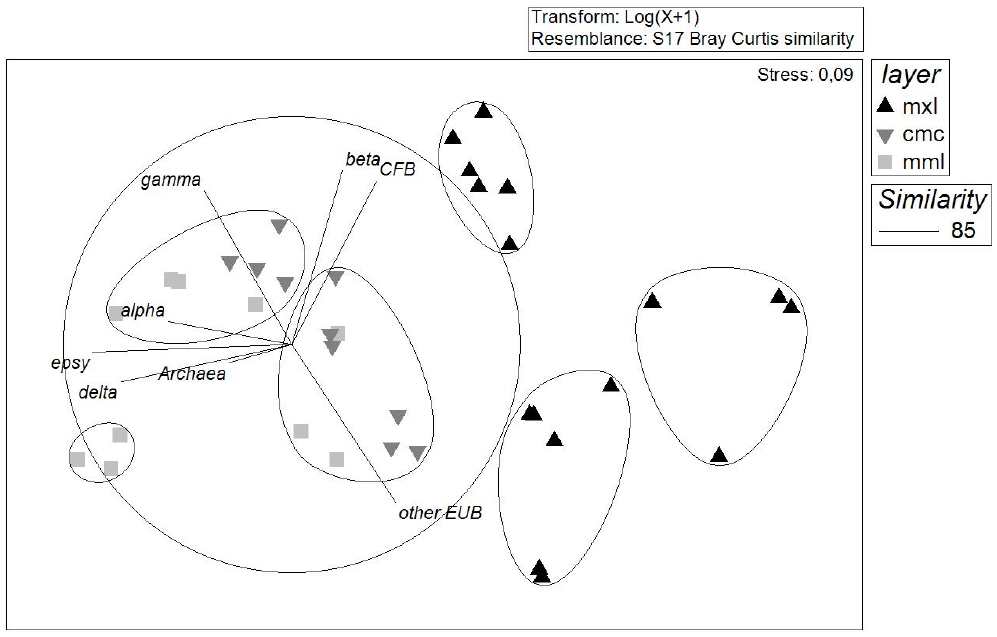
Figure 5. Non-metrical multidimensional scaling (nMDS) analysis (Bray-Curtis similarity matrix) computed on relative abundances of taxonomic groups detected by CARD-FISH (mxl: mixolimnion; cmc: chemocline; mml: